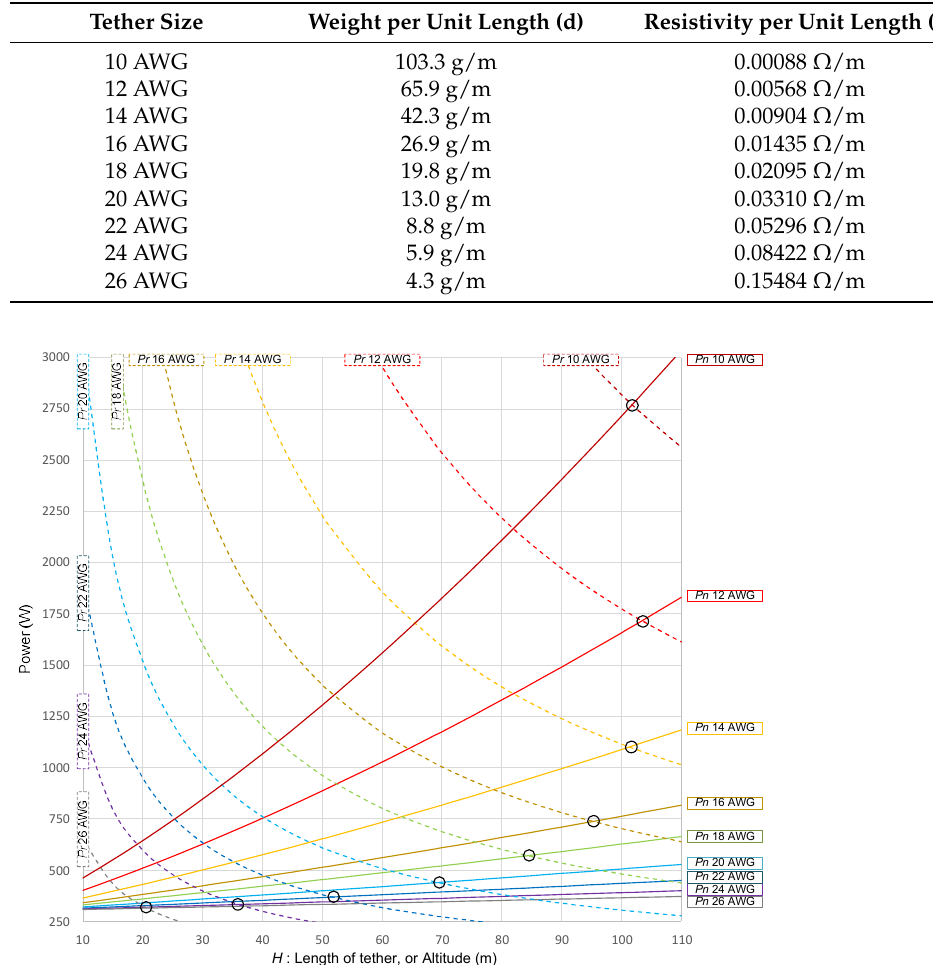
. Figure 5. Theoretical maximum altitude and the corresponding power needed and received by the hexacopter for different tether sizes. With the 1723 W power supply, selecting 12 AWG achieves 103 m altitude; with the 438 W power supply, selecting 20 AWG achieves 69 m altitude. 2.4. Margins for Safety For the proposed system, Figure 5 shows that the optimum tether size is 12 AWG which achieves 103 m theoretical maximum altitude with 1723 W power requirement; however, such a PSM is too heavy to be lifted by the hexacopter. The nominal power